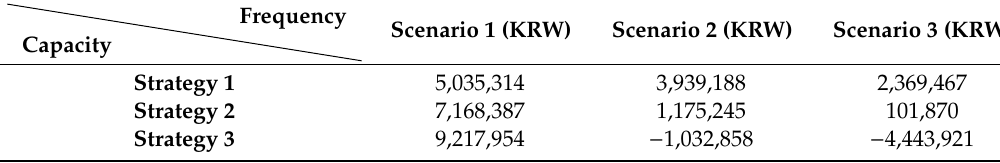
Table 4. Expected payo ff for each strategy in the Korean Republic Won